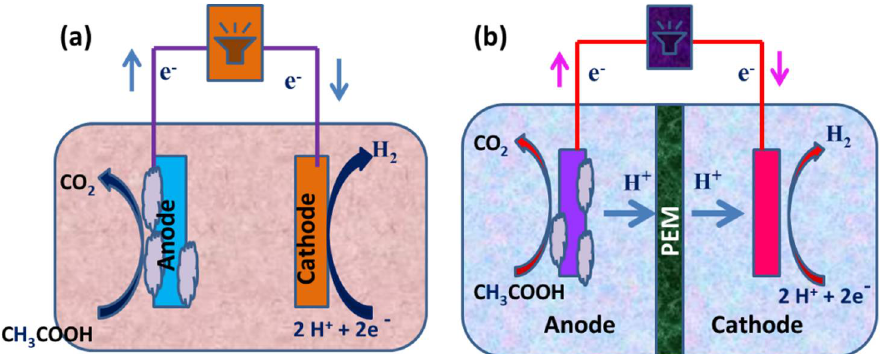
Figure 2. ( a ) Construction of a single-chambered MEC and ( b ) a schematic representation of a dual- chambered MEC. dual-chambered